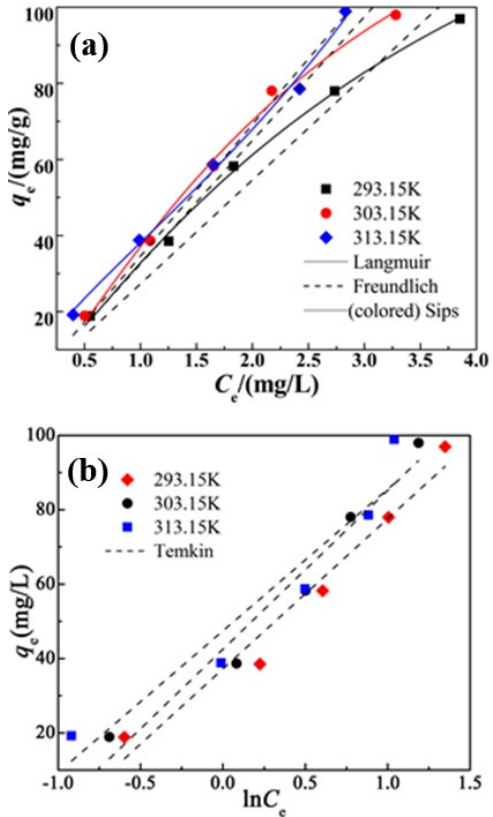
Figure 6. Comparison of the ( a ) Langmuir, Freundlich, Sips and ( b ) Temkin isotherm models for MV adsorption onto α -Fe 2 O 3 @PHCMs composites at different temperatures.